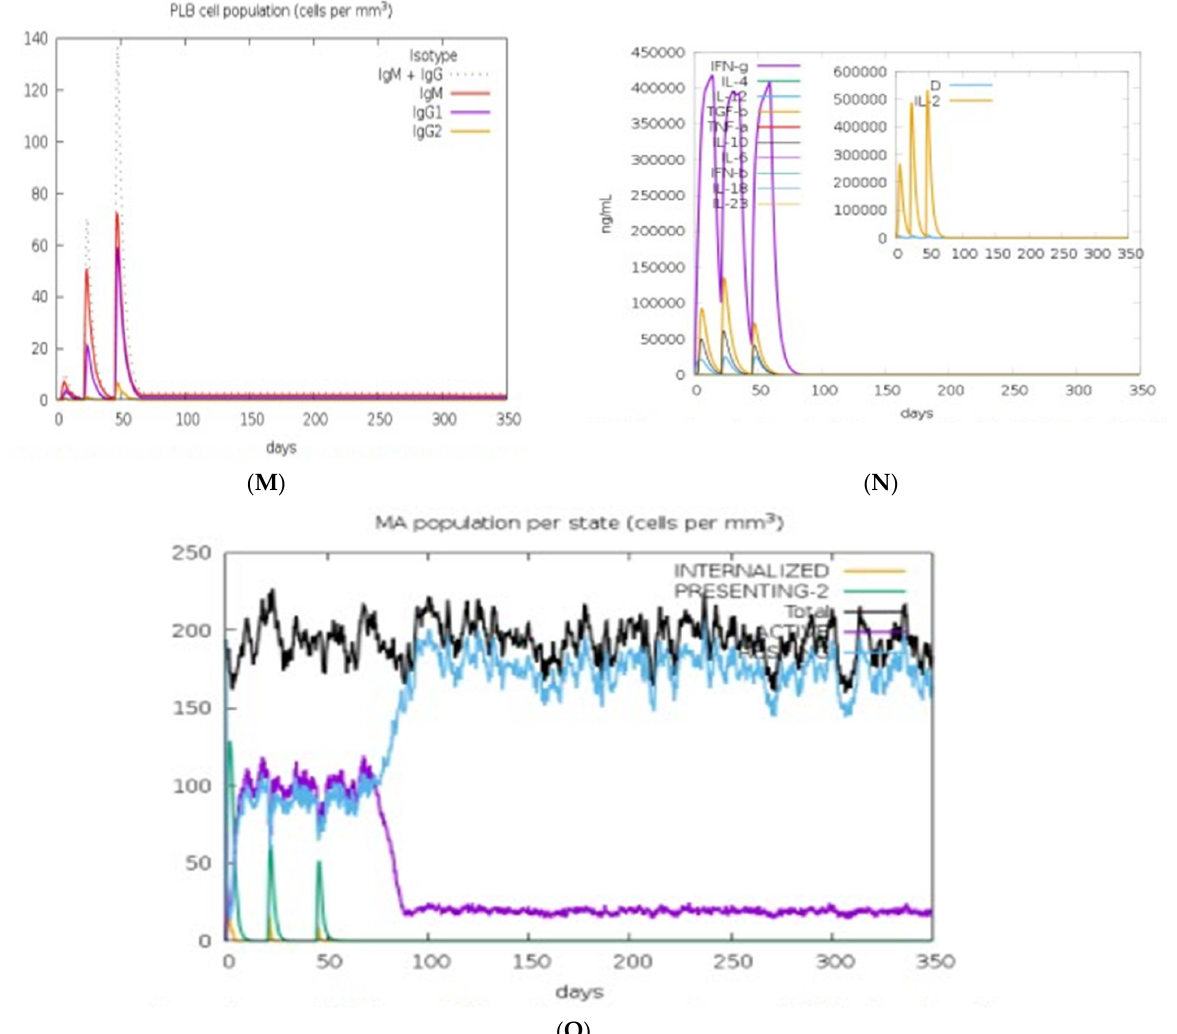
Figure 10. The induced immune cells by the mRNA vaccine. ( A ) Antigen and immunoglobulins of control. ( B ) Antigen and immunoglobulins of vaccine construct with antibodies subdivided per isotype. ( C ) B-lymphocytes population per entity-state (showing counts for active presenting on class II, internalized the Ag. Duplicating and anergic). ( D ) B lymphocytes showing total count and memory cells. ( E ) Epithelia cells population per state (showing total count broken down to active, virus-infected, and presenting on class I MHC molecule. ( F ) Dendritic cells population per state (showing the total number broken down to active, resting, internalized, and presenting the Ag). ( G ) Natural killer cells population showing total count. ( H ) CD8 T-cytotoxic lymphocytes count per entity-state. ( I ) CD8 T-cytotoxic lymphocytes count showing total and memory. ( J ) CD4 T-regulatory lymphocytes count with both total, memory, and per entity-state count plotted. ( K ) CD4 T-helper lymphocytes count subdivided per entity-state. ( L ) CD4 T-helper lymphocytes count with plot showing total and memory counts. ( M ) Plasma B-lymphocytes count subdivided per isotype (IgM, IgG1, and IgG2). ( N ) Cytokines plot showing the concentration of cytokines and interleukins. ( O ) Macrophages population per state (showing total count, internalized, presenting on MHC class II, active, and resting macrophages).